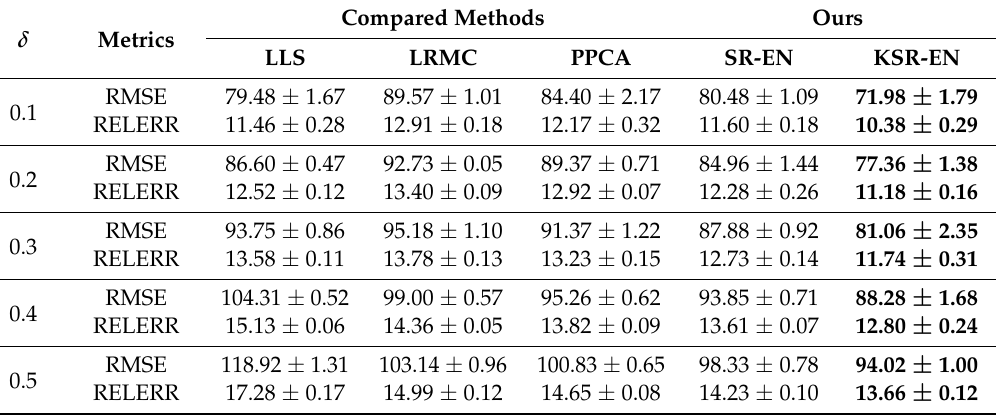
Table 4. Imputation error RMSE and RELERR obtained by different approaches under MIXED missing pattern. The best results are highlighted in